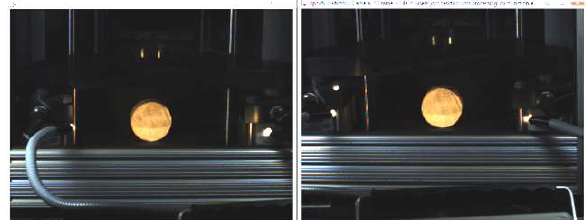
Figure 3. Fields of view for the two